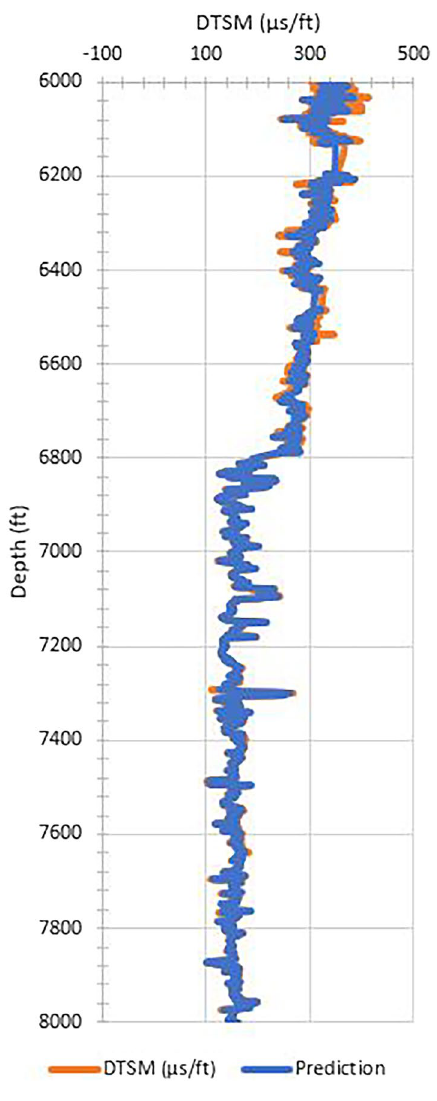
Fig. 8 Shear wave transit time versus